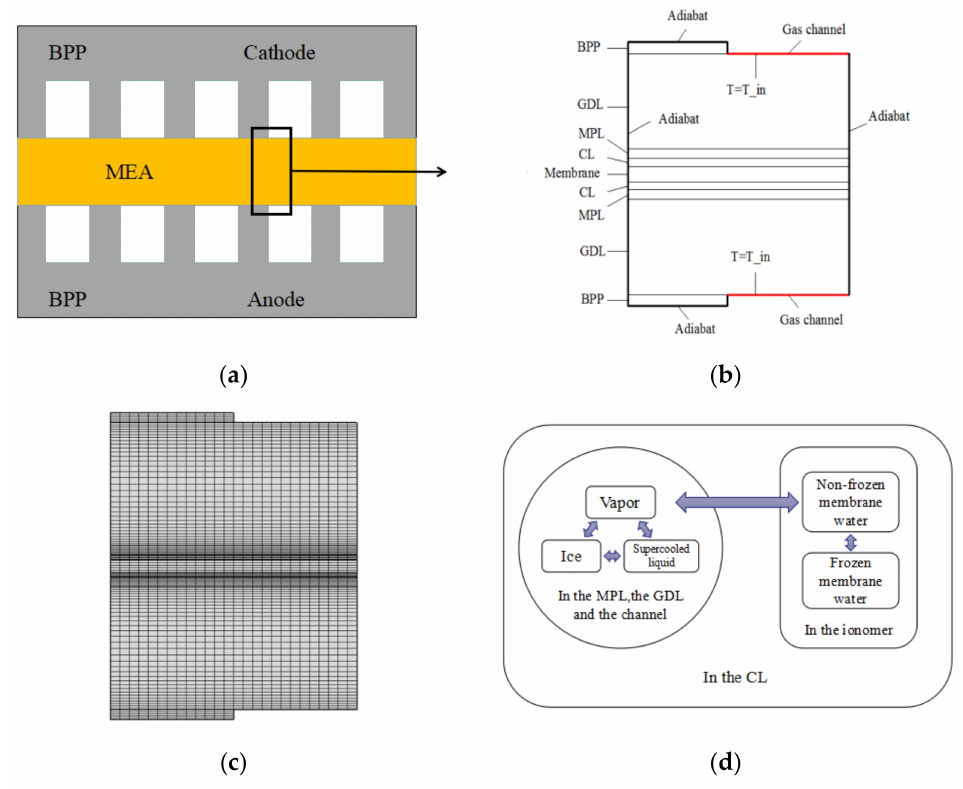
Figure 2. Model and water phase changes. ( a ) Geometry model; ( b ) Computational domain; ( c ) Mesh model; ( d ) Water phase changes in the